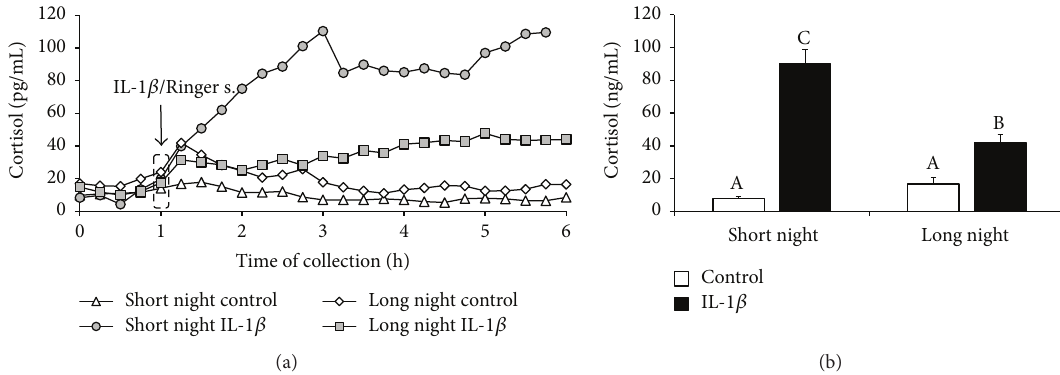
Figure 3: The effects of intracerebroventricular injection of interleukin- (IL-) 1 𝛽 (50 𝜇 g/animal) or Ringer’s solution (50 𝜇 L) on cortisol concentration in ewes taken during the short night (SN, May/June) and long night (LN, November/December) photoperiods. Experiments started one hour after sunset. (a) presents the temporal patterns of the mean concentration of the circulating cortisol ( 𝑛 = 6 animals per group) in 15min samples. (b) depicts the mean ( ± SEM; 𝑛 = 6 animals per group) concentration of cortisol for the period after IL-1 𝛽 or Ringer’s solution treatment (1 to 4h) of ewes during the SN and LN photoperiods. Different capital letters indicate significant ( 𝑃 < 0.05 ) differences according to a two-way ANOVA followed by Tukey’s post hoc